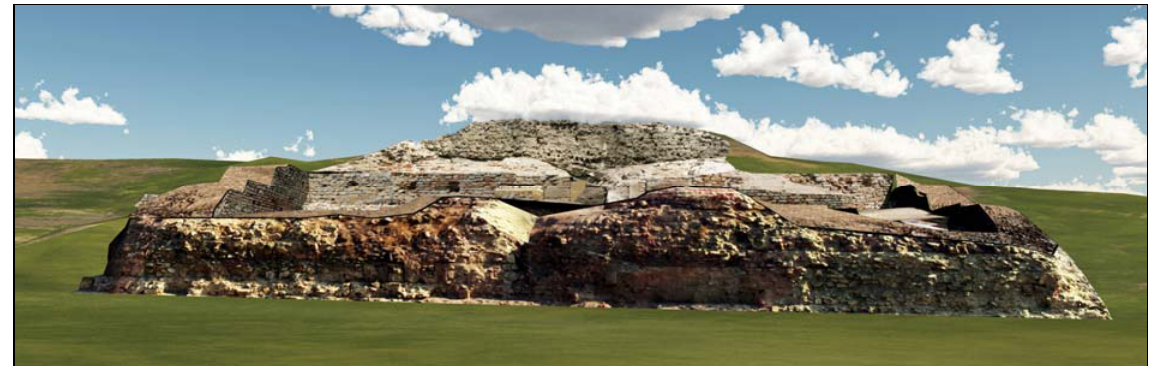
Figure 13. 3D model of the Large Tower rendered in Vue 7 xStream . Main view, from the